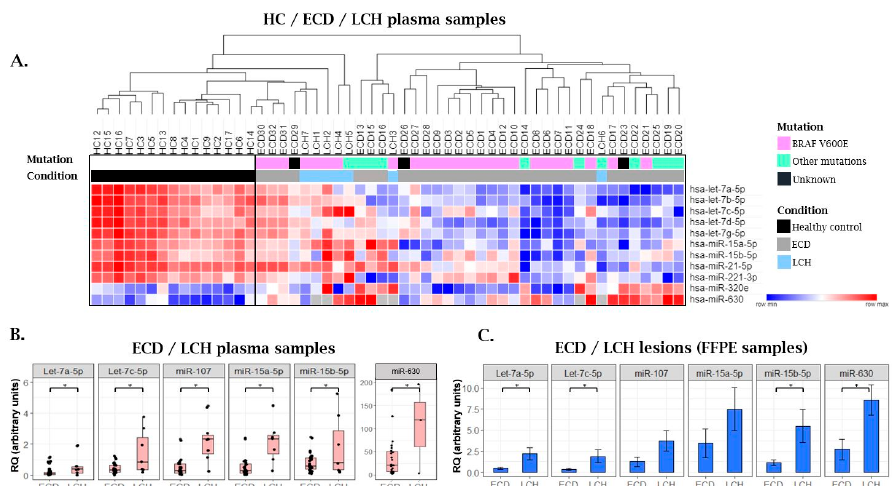
Figure 6. ( A ) A heat map illustrating supervised clustering of a subset of miRNAs that were differentially expressed in samples from ECD and LCH patients as compared with samples from healthy controls (HC). At each row, red and blue indicate the relatively high and low miRNA expression, respectively, as measured by qRT-PCR. Missing values are indicated in gray. Due to the lack of biological material, miR-630 was evaluated in 3 LCH plasma samples and not 7 plasma samples. “Other mutations” include BRAF deletion and NRAS, KRAS, MAP2K2, and MAP2K1; ( B ) Six miRNAs that were significantly higher in plasma samples of LCH patients as compared with ECD were analyzed in; ( C ) ECD ( n = 5); and LCH ( n = 4) lesions measured by qRT-PCR, normalized to spike-in control cel-miR-39. RQ, relative quantification. Bars represent low and high expression of the miRNA + SEM.